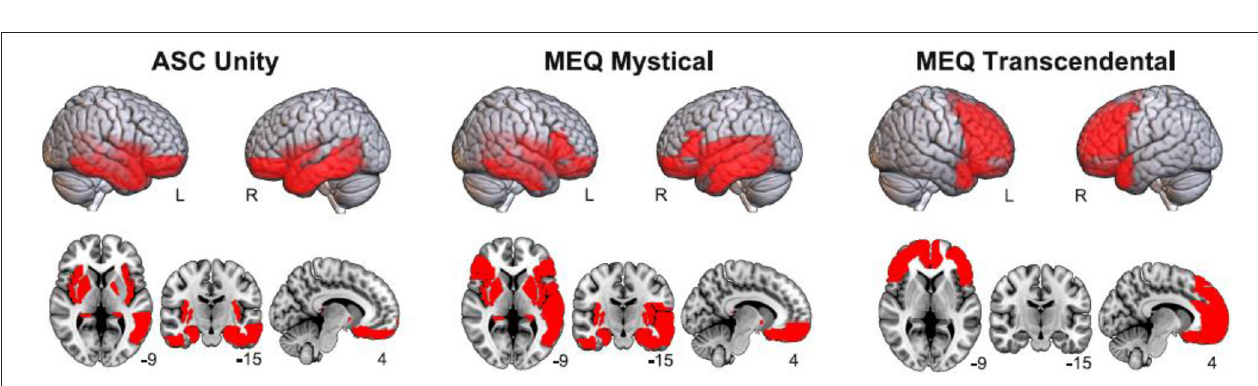
FIGURE 3 | Anatomical rendering (top) and volumetric display (bottom) of AAL regions where significant negative correlations between theta power and questionnaire subscales (5D-ASC Unity, MEQ30 Mystical and MEQ30 Transcendental) were found.